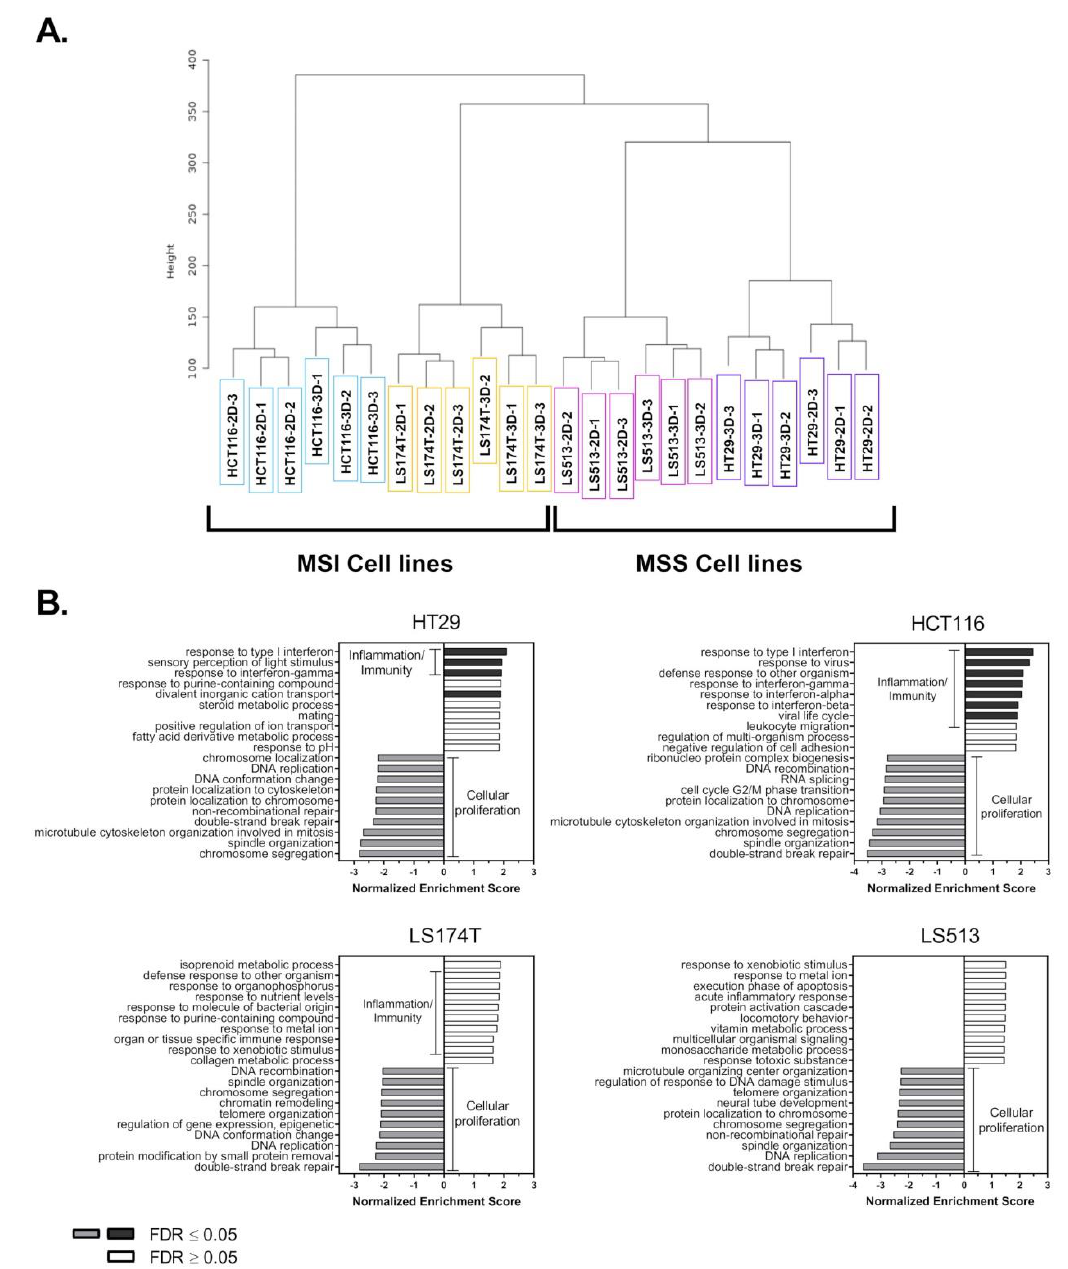
Figure 1. Transcriptomic analysis of colorectal cancer cell lines grown in 2D and 3D culture conditions. ( A ) CRC cell lines (HCT116, HT29, LS513 and LS174T) were cultured in 2D and 3D, RNA extracted and mRNA analyzed through RNA sequencing. Sample data ( n = 3) were pooled and normalized to compute the cluster dendrogram shown in ( A ). ( B ) Gene set enrichment analysis (GSEA) was performed using the Geneontology, Biological process noRedundant database among the genes significantly overexpressed (Log2foldchange 2Dvs3D > 1) and downregulated (Log2foldchange 2Dvs3D < − 0.5) in 3D vs. 2D culture conditions. The significantly enriched and reduced pathways are shown in ( B ).